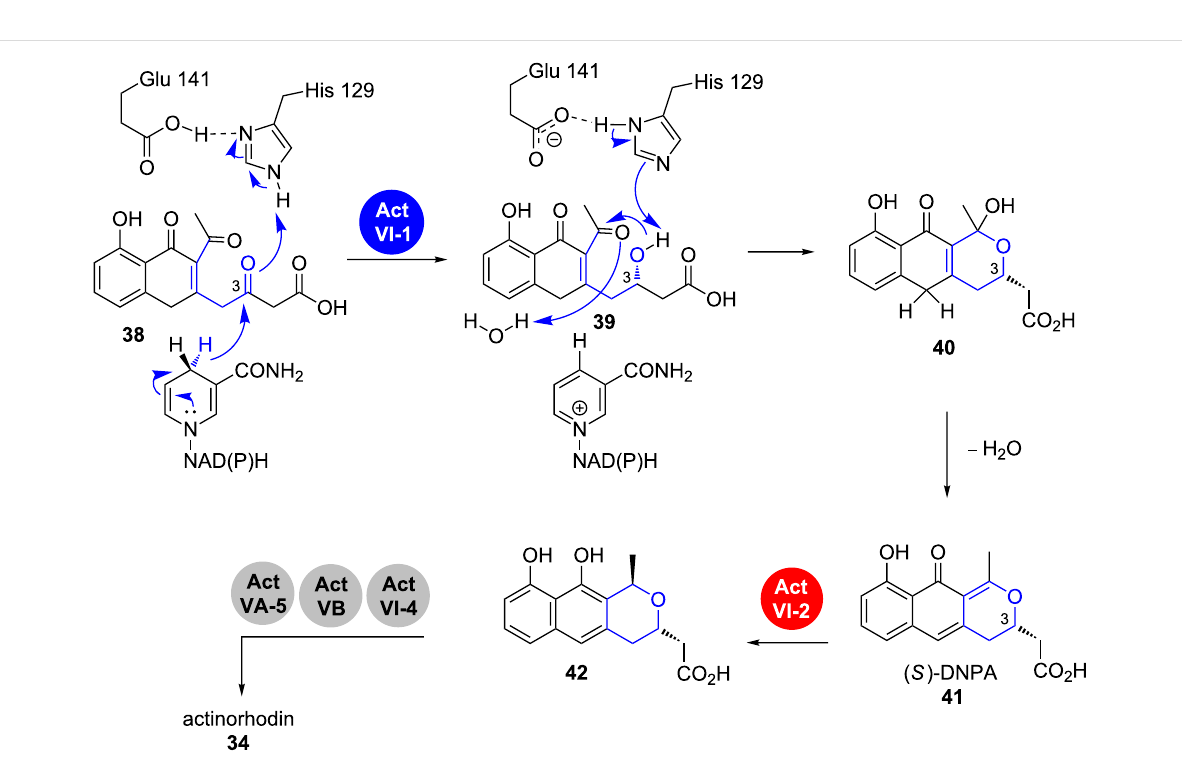
Scheme 6: Pyran-ring formation in actinorhodin ( 34 ) biosynthesis. DNPA: 4-dihydro-9-hydroxy-1-methyl-10-oxo-3 H -naphto[2,3- c ]pyran-3-acetic acid. Modified from